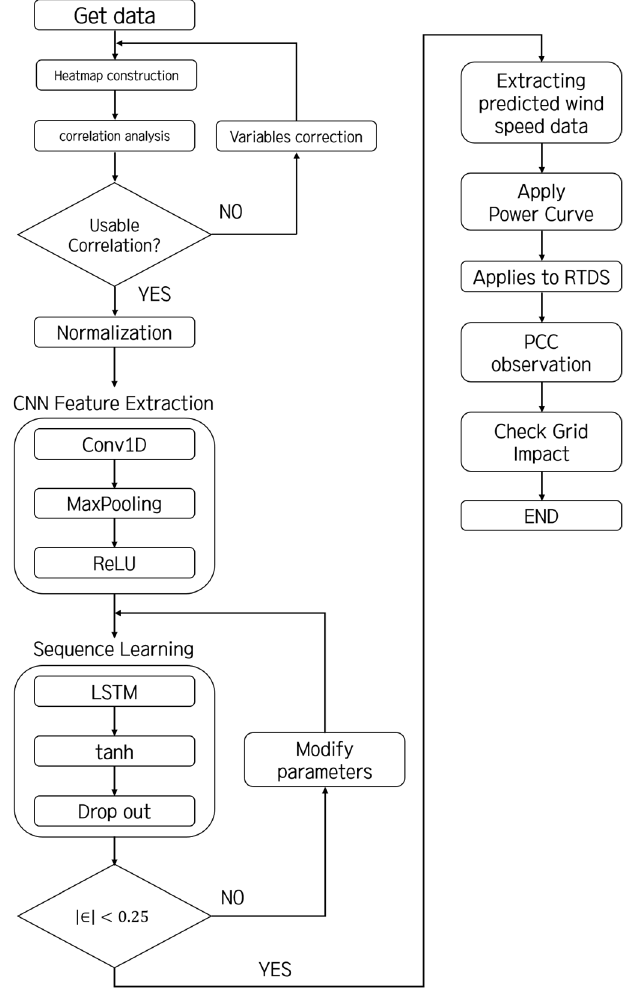
Figure 5. Overall simulation processes.